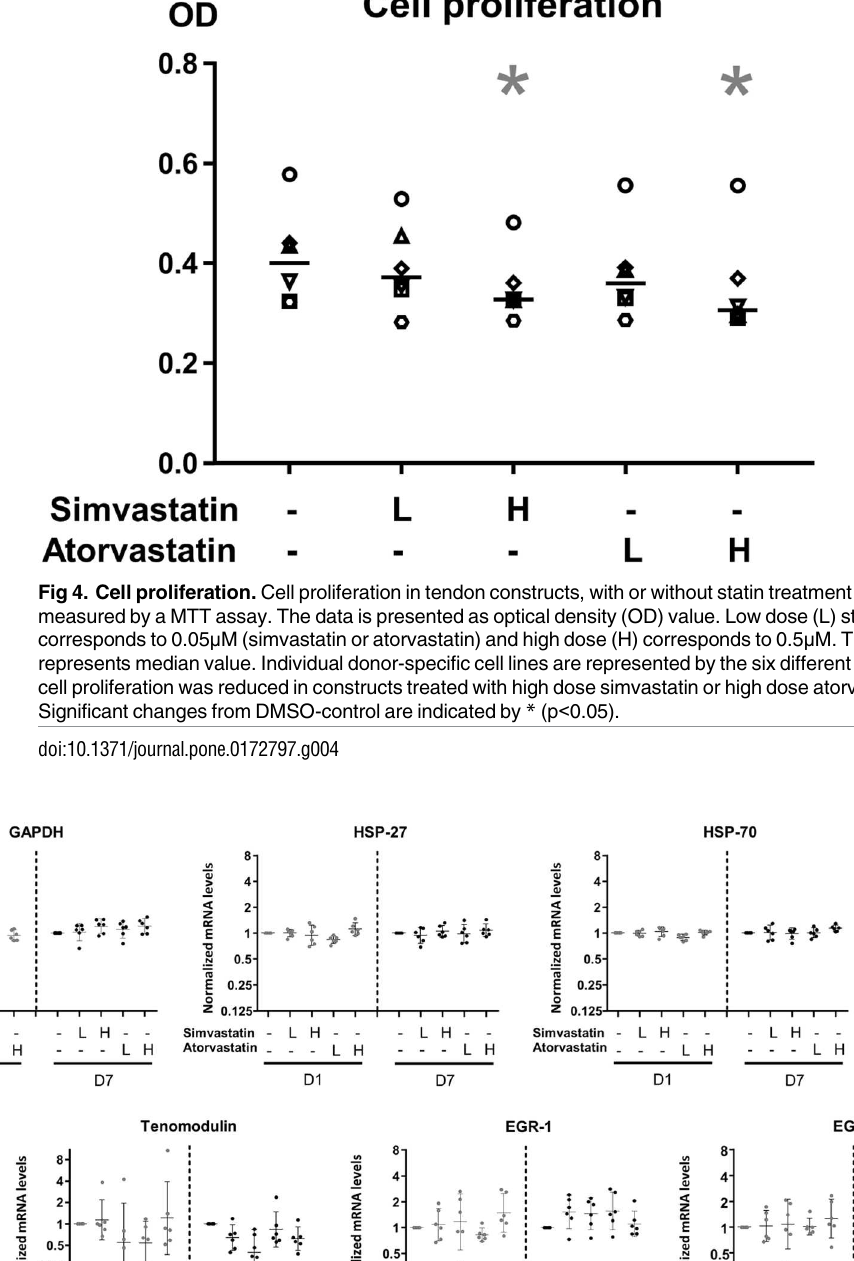
PLOS ONE | DOI:10.1371/journal.pone.0172797 March 6,